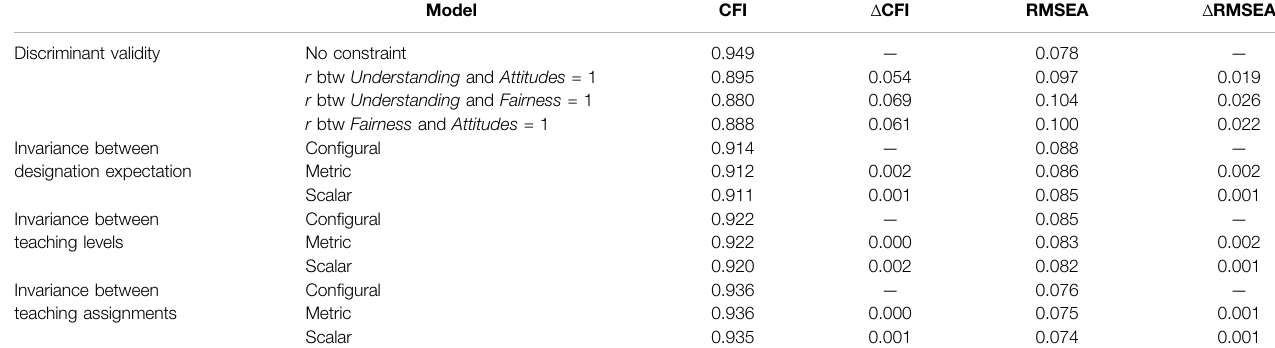
TABLE 2 | Nested model